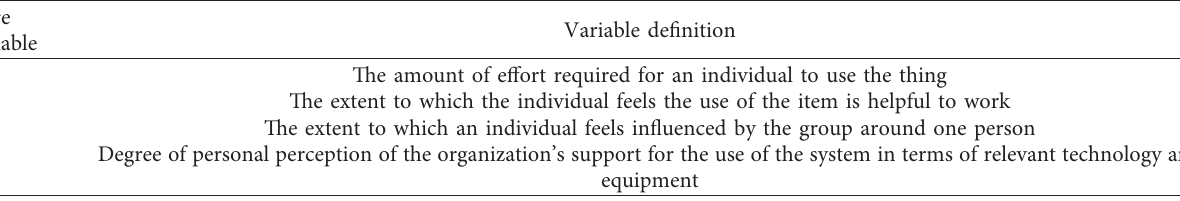
Table 1: UTAUT core variables and